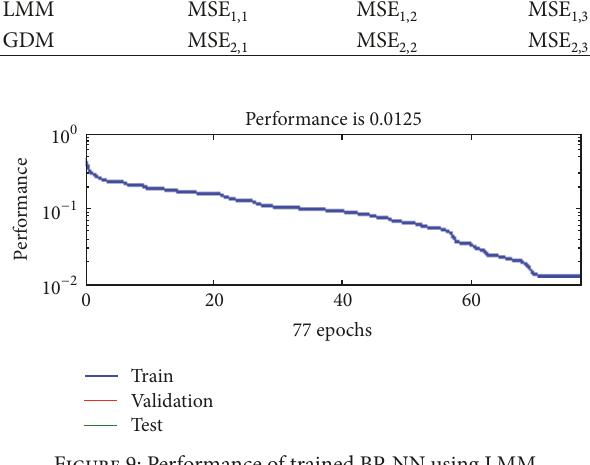
Figure 9: Performance of trained BP-NN using LMM.